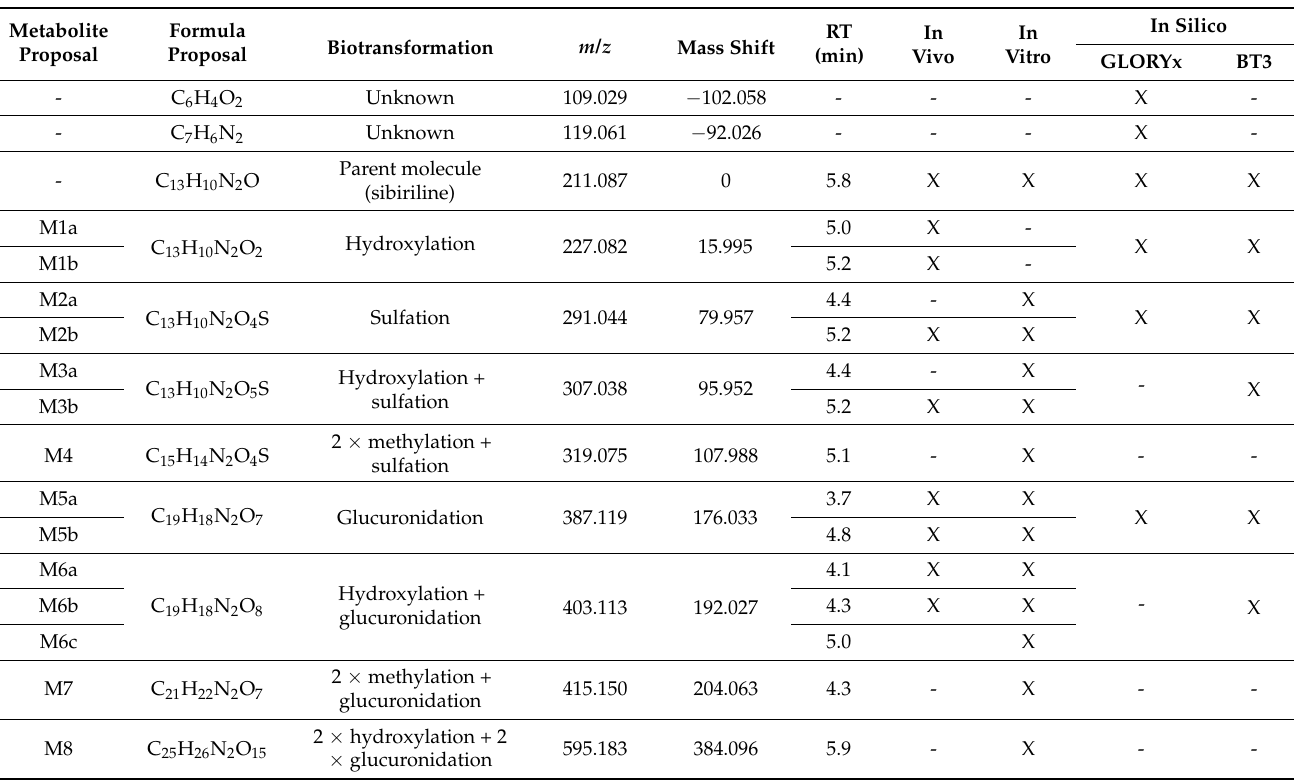
Table 2. Putative identified compounds or metabolites contained in the Sibiriline molecular network. RT: retention time; BT: Biotransformer 3; X = presence; - =